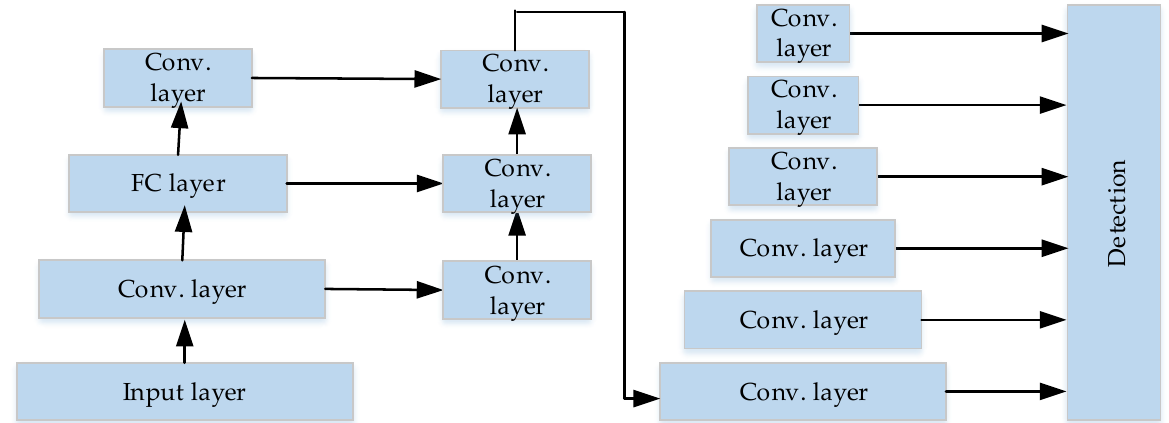
13 of 45 Figure 8. The structure of DSSD. The orange boxes are convolutional layers, the light-orange boxes are pooling layers, the lilac boxes are de-convolutional layers, the lilac gates represent the concate- nation of the convolution and the deconvolution. There are 10 convolutional layers, 1 pooling layer and 5 de-convolutional layers in the main pipeline. The planes reflect the size of the feature maps, the thickness reflects the dimension of the feature map. The six branches on the top right of the figure represent the prediction module, i.e., classification and object localization module. RSSD improves SSD algorithm from the following two aspects: (A) RSSD uses the classification networks to strengthen the connection of feature maps between different layers, which reduces the duplicate frames; (B) RSSD increases the number of feature maps in the multi-scale feature map prediction, increasing the robustness of the detection of small objects. In the network structure of RSSD, pooling and deconvolution are implemented sim- ultaneously. Before the concatenation, Batch Normalization (BN) operations are per- formed on the feature maps to unify the feature distribution of the data, thereby improv- ing the detection accuracy. FSSD emphasizes on the fusion of shallow and deep features. Shallow features have a low semantic level, while deep features have a high semantic level, if they are directly fused, these features will not be able to make full use, and the information loss may occur.